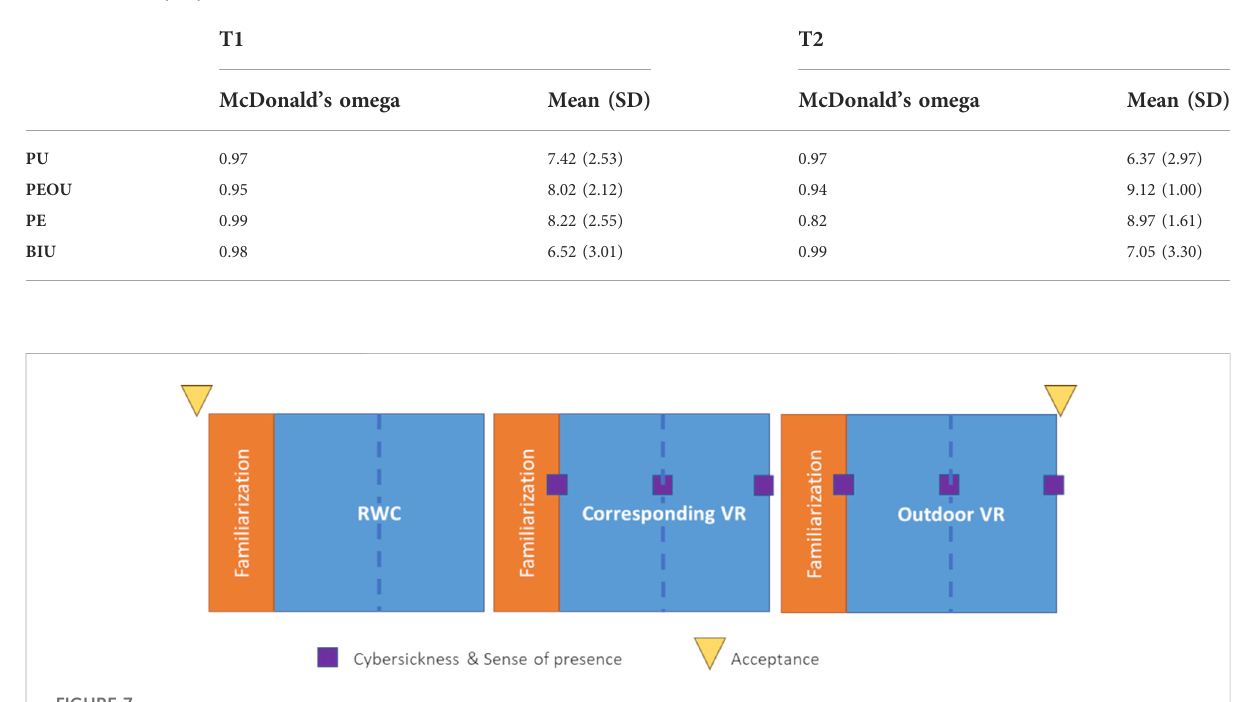
FIGURE 7 Experimental procedure in a speci fi c order: real-world condition (RWC), corresponding virtual reality (VR) and outdoor virtual reality (VR). The experimental conditions were presented in a randomized order. The three conditions consisted of a familiarization period (in orange) and an experimentalphase(inblue).Thedottedbluelinerepresentsthetwoblocksof10pointingtrialspercondition.Duringtheexperimentalphaseofeach condition, feet positions were recorded for each trial to compute gait parameters. Cybersickness and sense of presence were measured at the endofthefamiliarizationperiodandattheendofthetwopointingblocksofeachvirtualcondition.Acceptancewasmeasuredatthebeginningofthe experiment to quantify acceptance before use, and once again, after the second RVC, to quantify their acceptance after